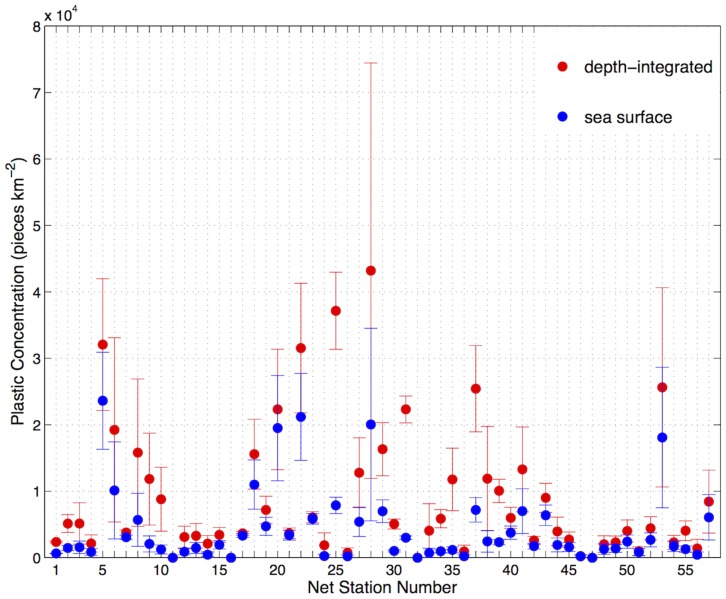
Mean and standard error of sea surface (Cs) and depth-integrated (Ci) plastic concentrations.Blue represents mean and standard error of Cs and red represents mean and standard error of Ci.